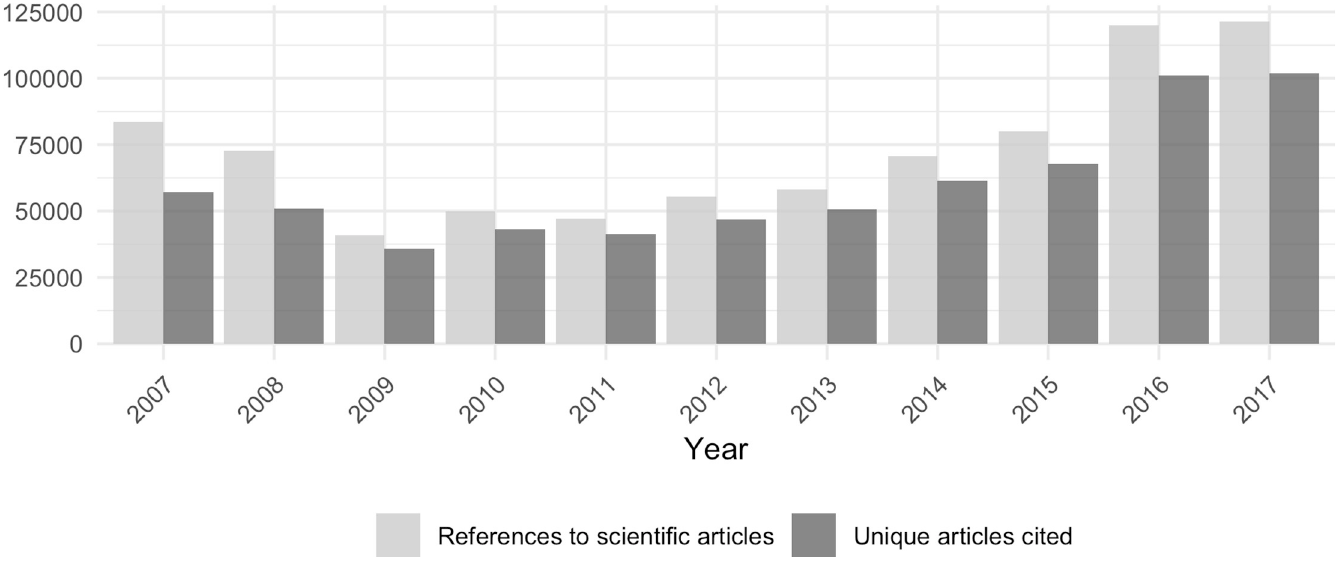
Fig 2. Annual values of total references made by Wikipedia and single articles cited.